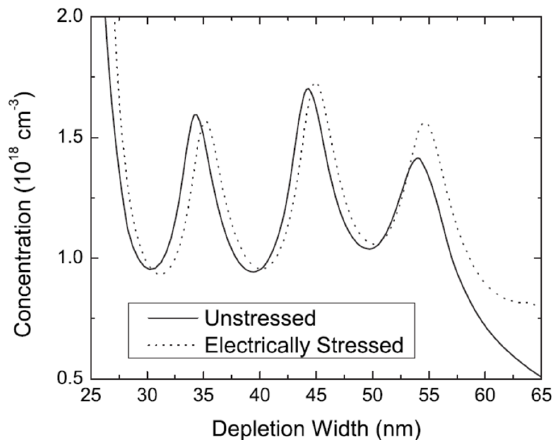
Figure 17. ACD profile of an unstressed and electrically stressed device as a function of depletion width. Reproduced with permission. [62] Copyright 2010, AIP.